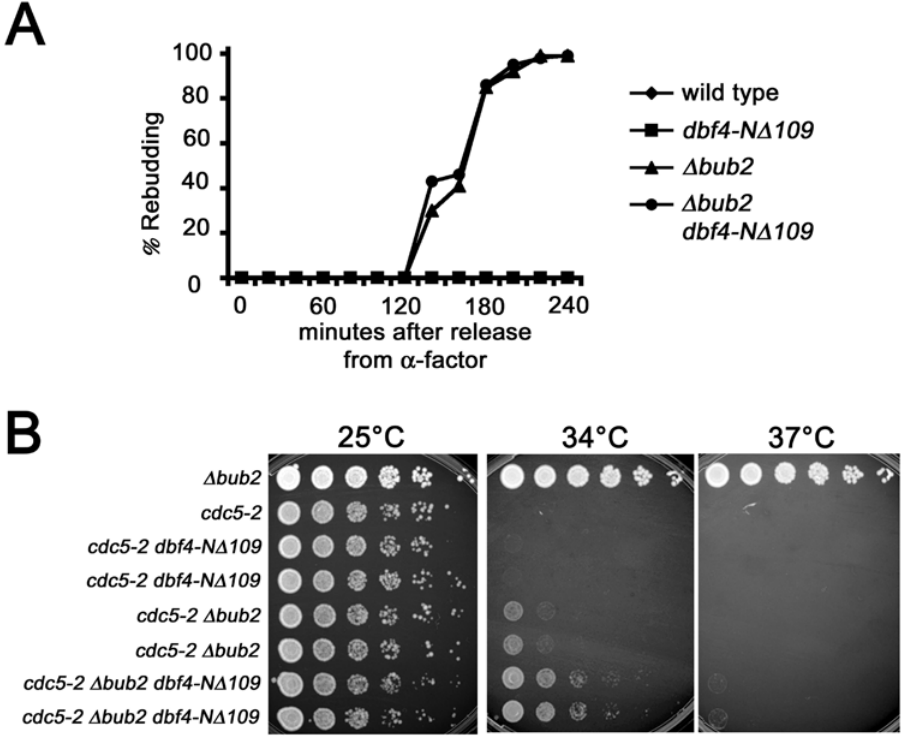
Figure 6. DBF4 regulates mitotic exit independently of BFA1 - BUB2 . (A) Deletion of the DBF4 polo-box interacting region does not cause rebudding. W303-1A, M1652, M1656 and M1860 were synchronized with alpha-factor and released into YPD containing 15 ug/ml of nocodazole at 30 u C. Samples were quantitated for the percentage of rebudded cells (large budded cells with a new bud). (B) Deletion of BUB2 and the DBF4 PIR cooperate to suppress the growth defect of cdc5-2 . Strains of the indicated genotypes were spotted at 5-fold serial dilutions on YPD and grown at increasing temperature. Two isolates are shown for the cdc5-2 recombinants.